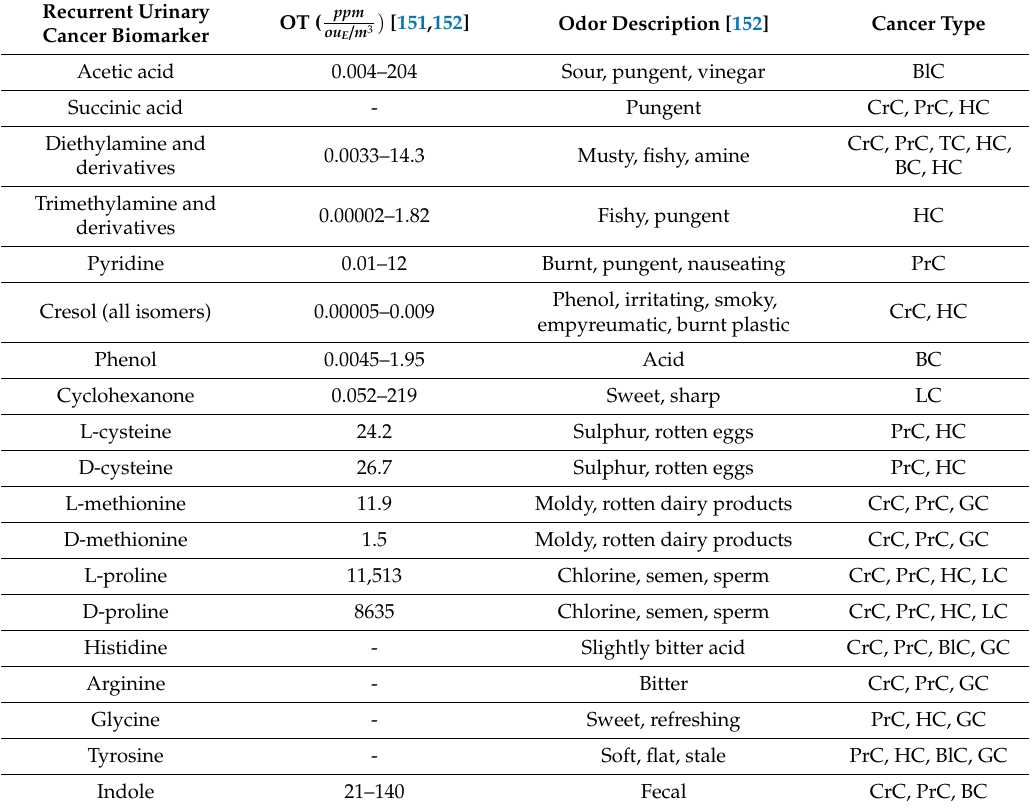
Table 12. Odor properties of recurrent biomarkers for di ff erent cancer